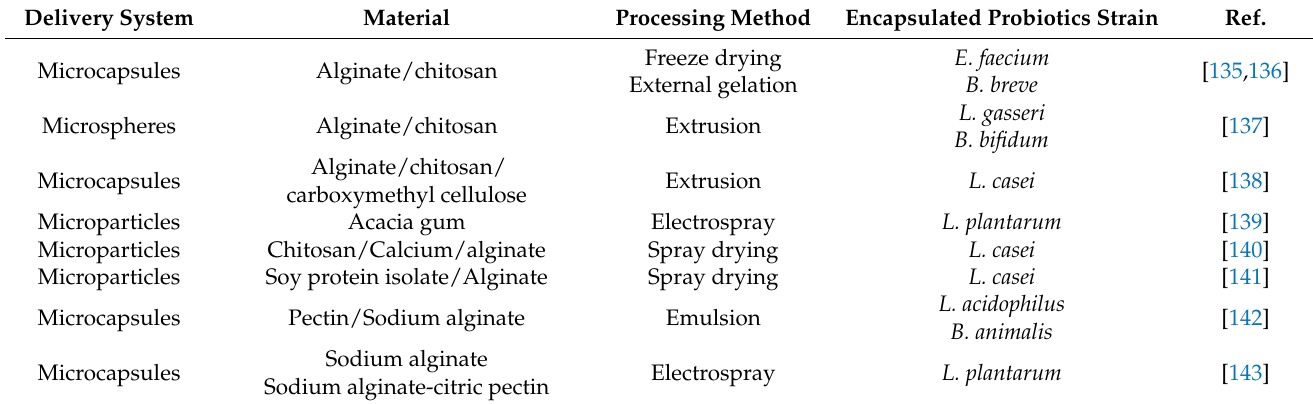
Table 3. Recent studies in probiotic encapsulation employing